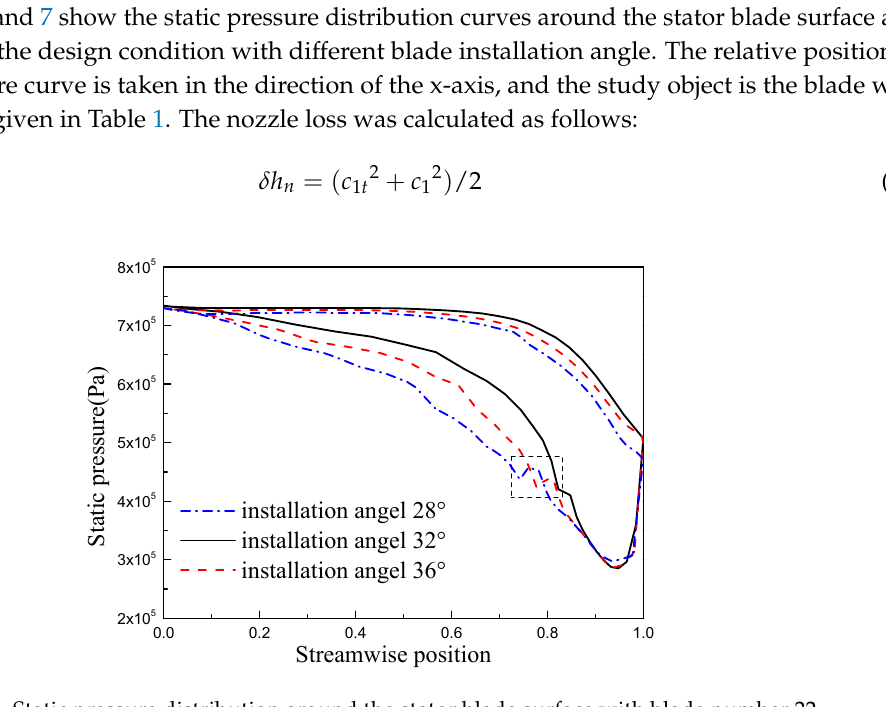
Figure 6. Static pressure distribution around the stator blade surface with blade number 22.